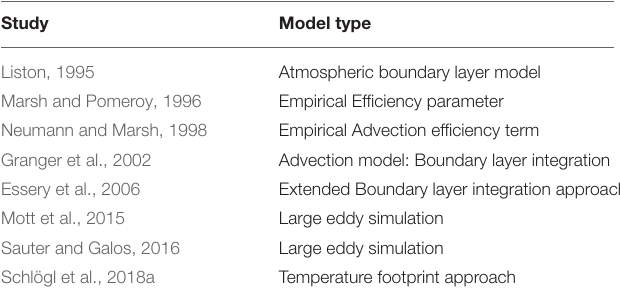
TABLE 3 | Approaches to describe local heat advection (Literature since